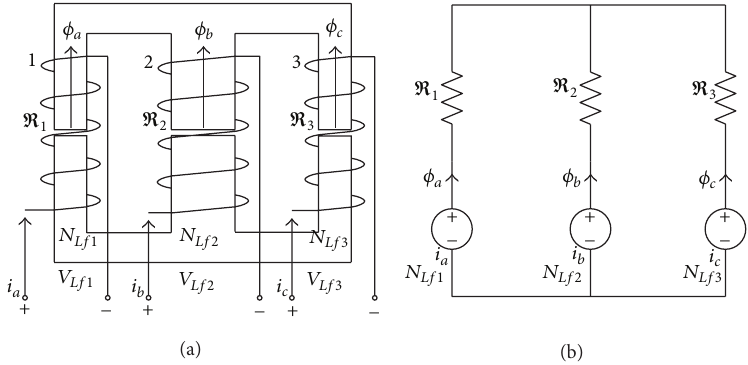
Figure 7: Three-phase integrated inductors with five magnetic limbs: (a) three-phase magnetic core with five limbs, (b) magnetic